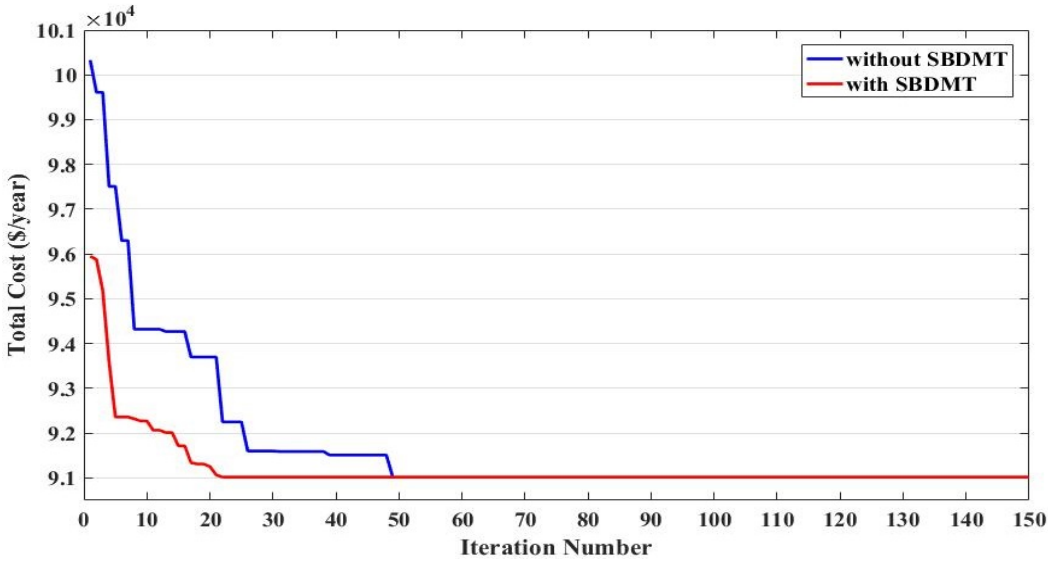
Figure 5. Convergence characteristics of PODESCA for the 85-bus system.